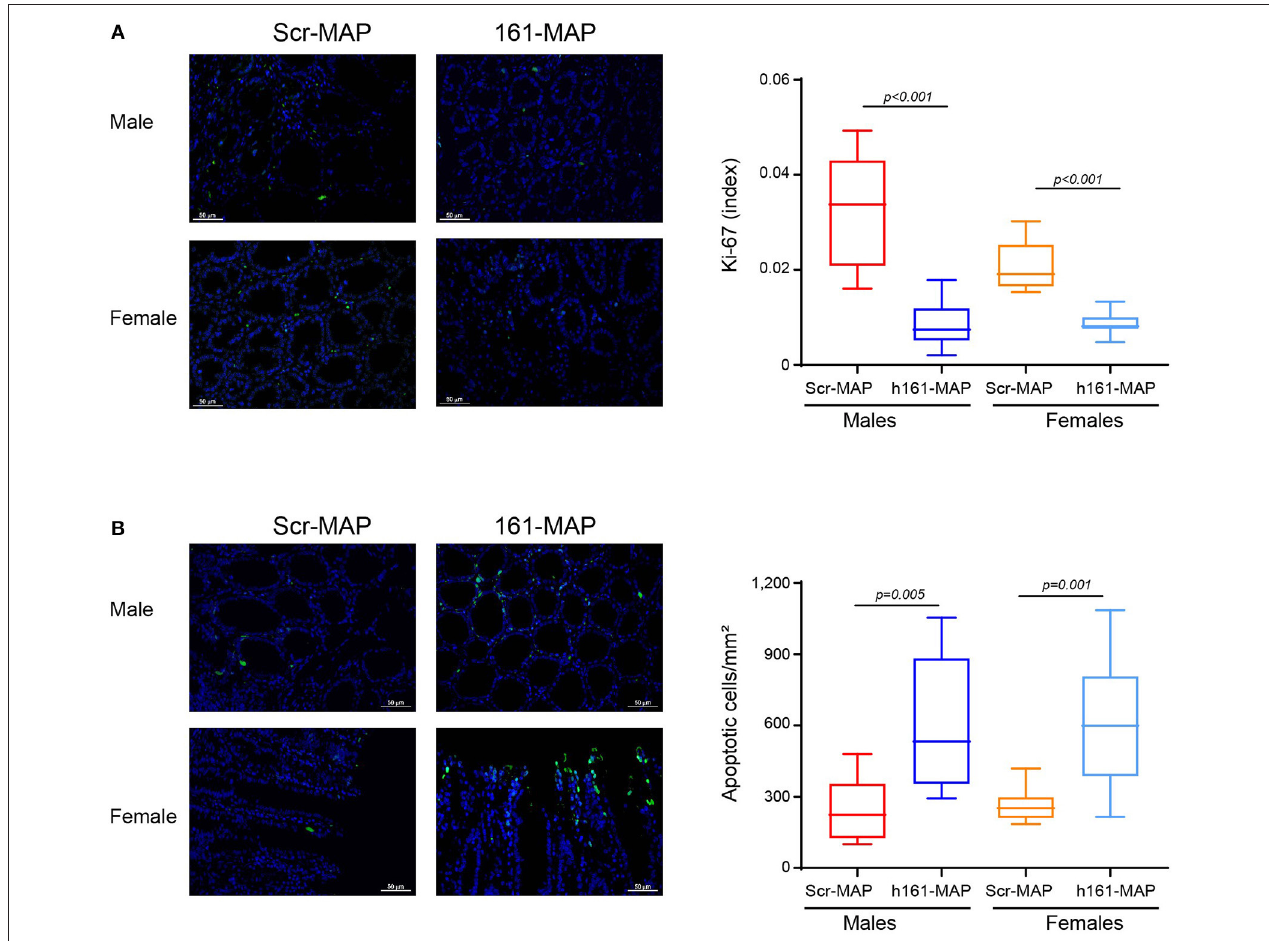
FIGURE 6 | 161-MAP active vaccination reduces proliferation and enhances apoptosis. Colon tissue sections were stained for Ki-67 or DNA strand breaks (TUNEL assay). (A) Representative images of Ki-67 staining (scale bar is 50 µ m) and their quantitation (Green, proliferating cells; blue, DAPI staining of nuclei; white, merged co-localization, n = 3–4 in each group). (B) Representative images of the TUNEL assay and their quantitation. (Green, apoptotic cells; blue, DAPI staining of nuclei; white, merged co-localization, n = 3–4 in each group). Scale bar is 50 µ